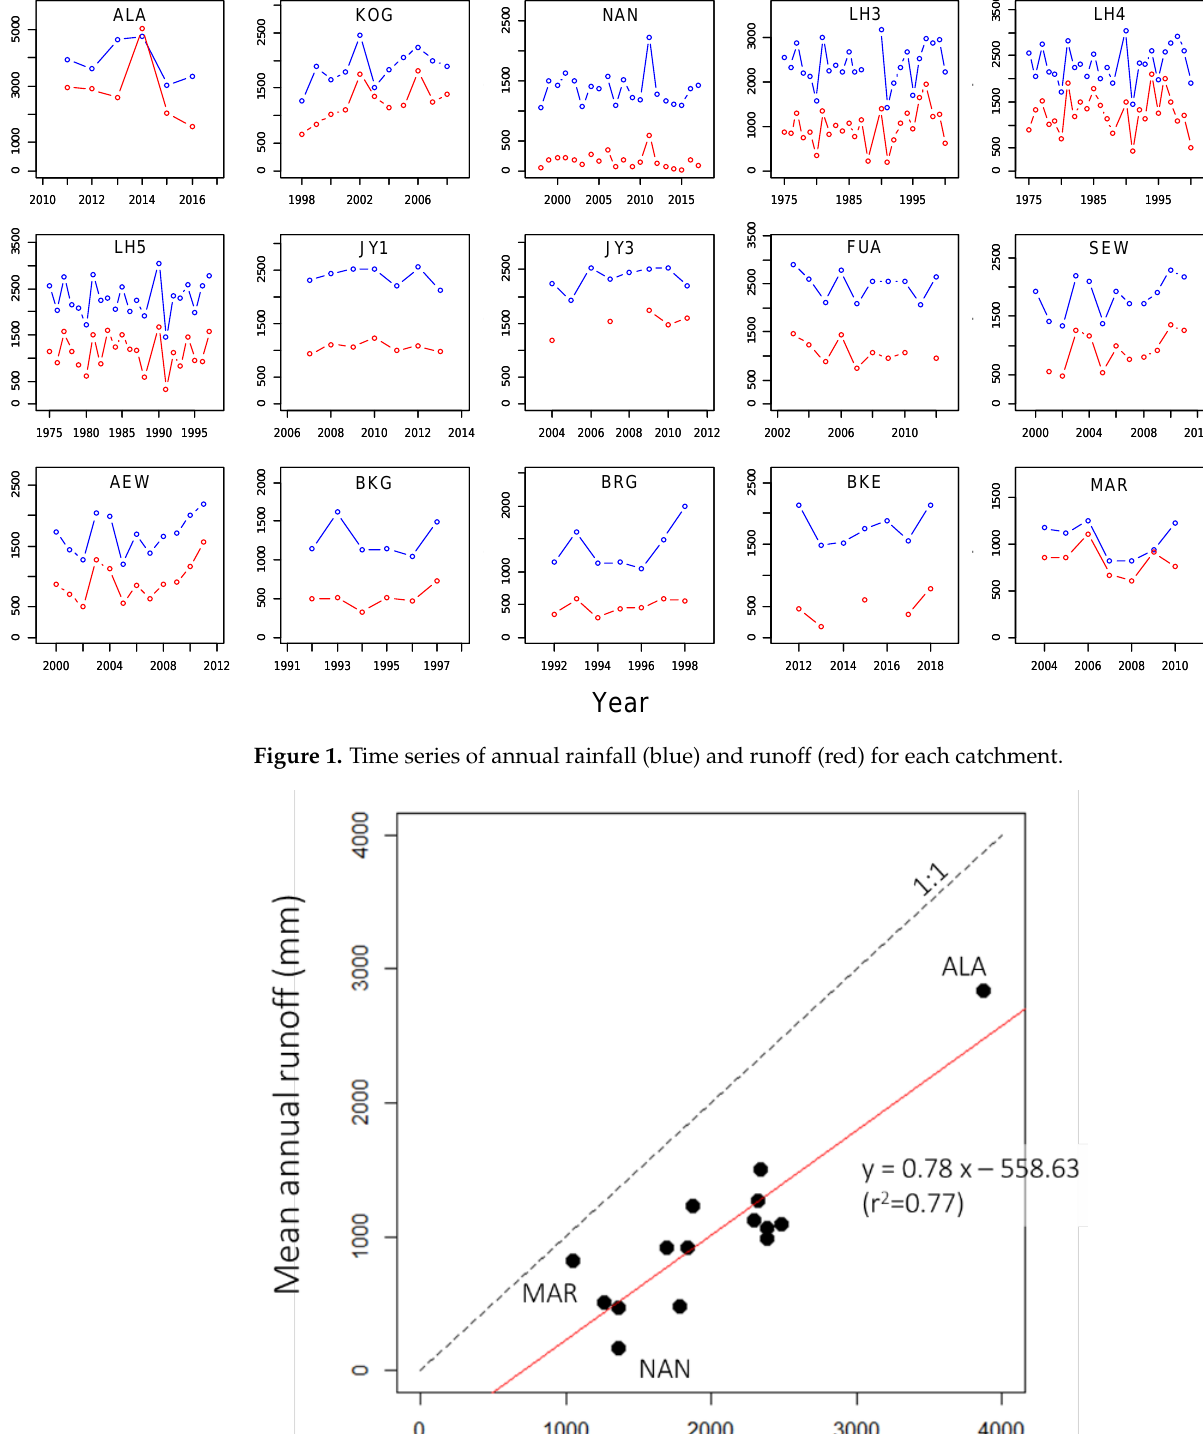
Figure 1. Time series of annual rainfall (blue) and runoff (red) for each catchment.